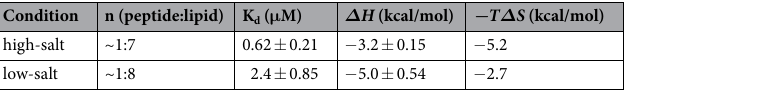
Table 3. Thermodynamic parameters of the LPA-GAP43IQ interaction obtained from the ITC measurements depicted in Fig.